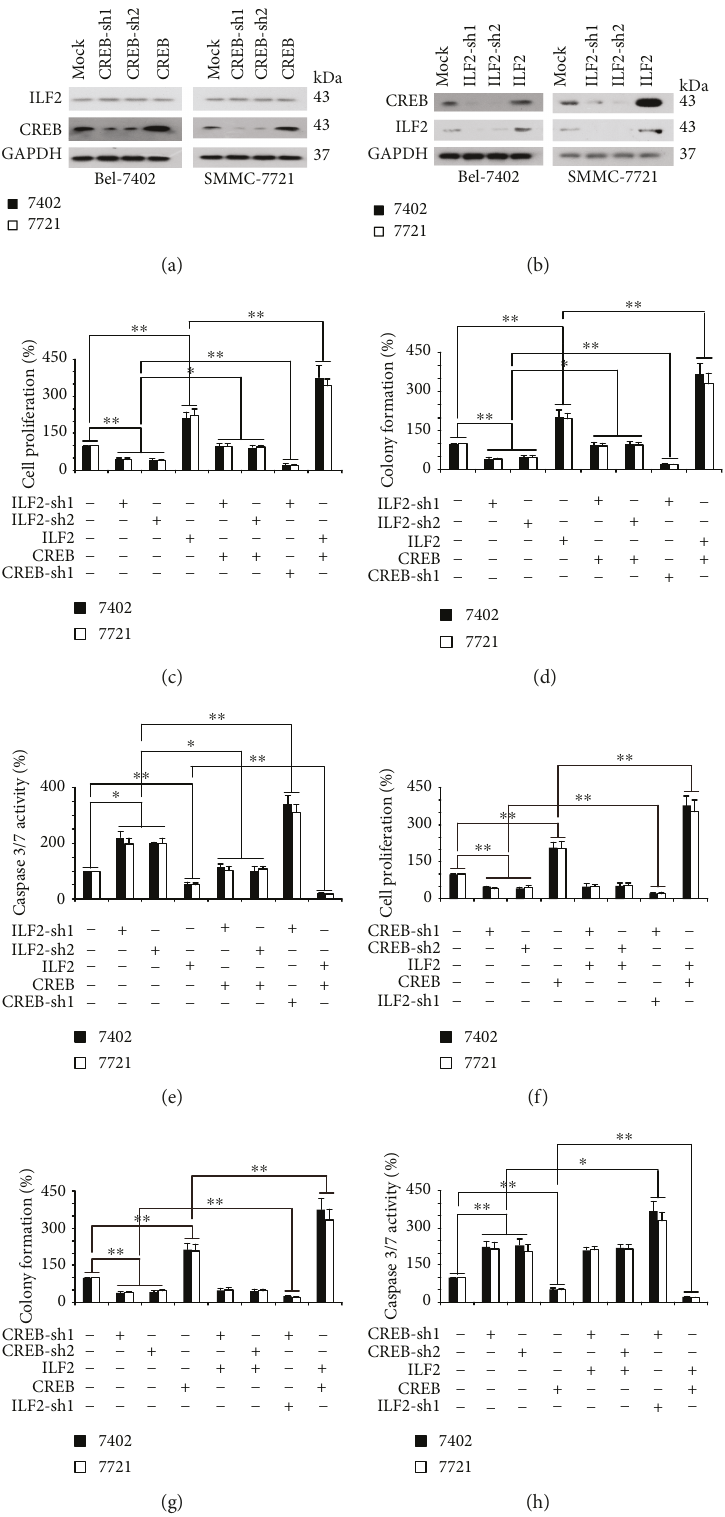
Figure 3: ILF2 is an upstream protein of CREB. (a, b) The ILF2, CREB, and GAPDH protein expression levels in control (infected with shRNA against GFP), Bel-7402, or SMMC-7721 cells with knockdown and overexpression of CREB or ILF2 were measured by western blotting. (c – e) Cell proliferation, colony formation capacity, and apoptosis status in control cells and Bel-7402 or SMMC-7721 cells with indicated plasmids transfected. (f – h) Cell proliferation, colony formation capacity, and apoptosis status in control cells and Bel-7402